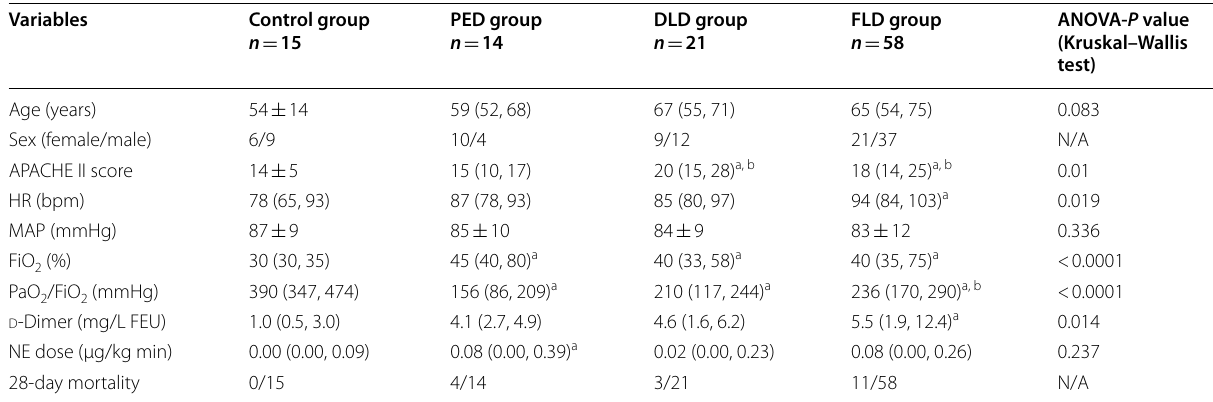
Table 1 Demographics, clinical characteristics in four